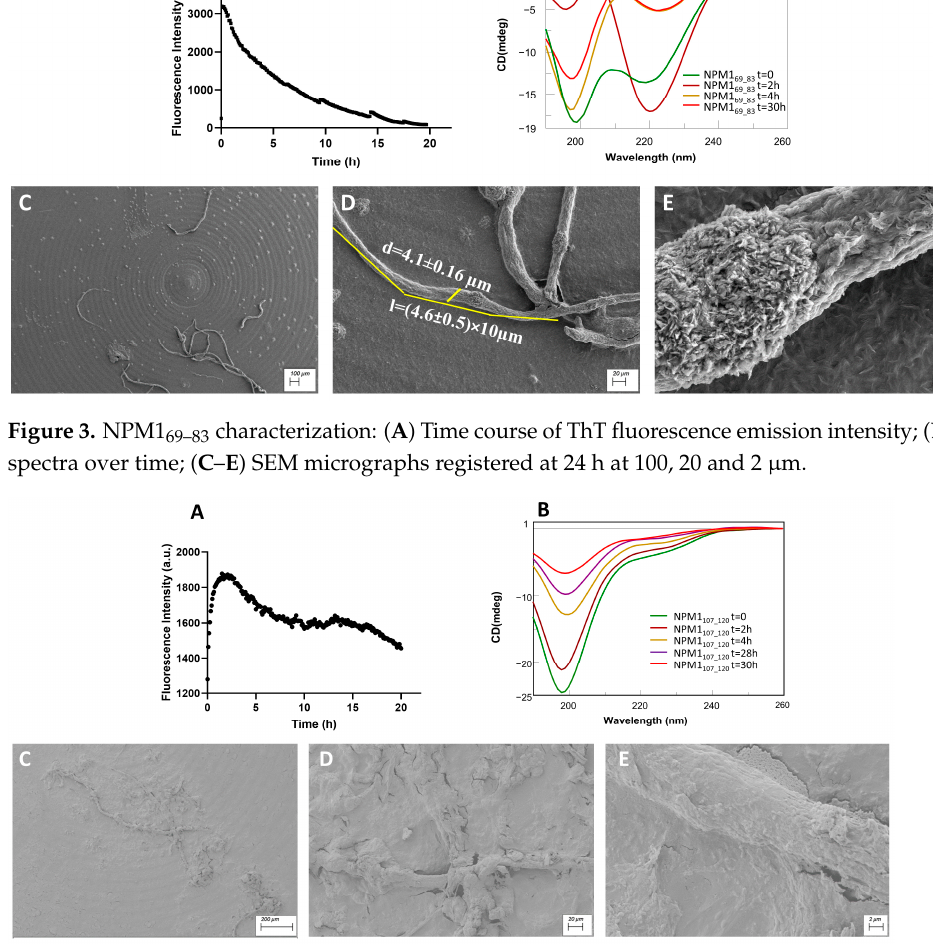
Figure 4. NPM1 107–120 characterization: ( A ) Time course of ThT fluorescence emission intensity; ( B ) CD spectra over time; ( C – E ) SEM micrographs registered at 24 h at 200, 20 and 2 µm.